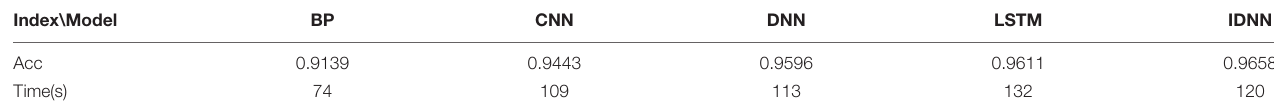
TABLE 5 | Performance comparison of each